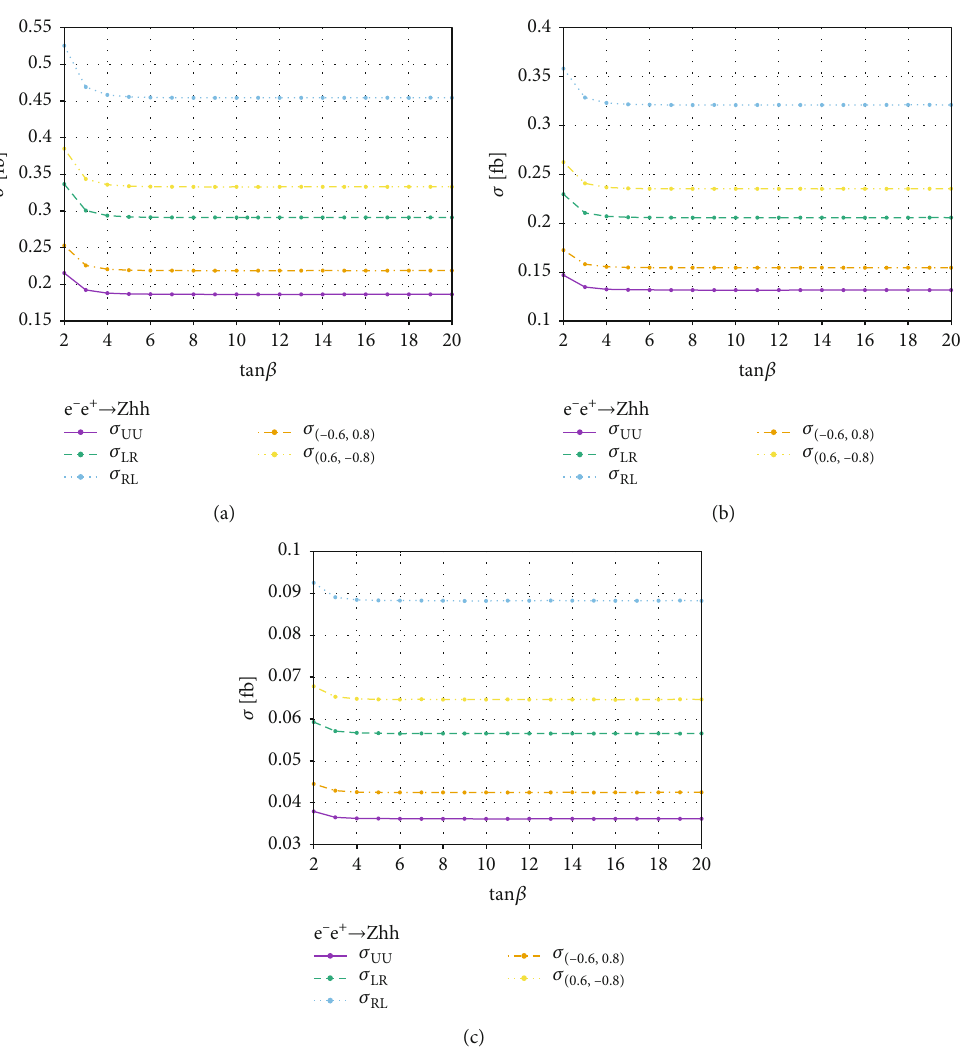
ffiffi p = 1 TeV , and (c) s